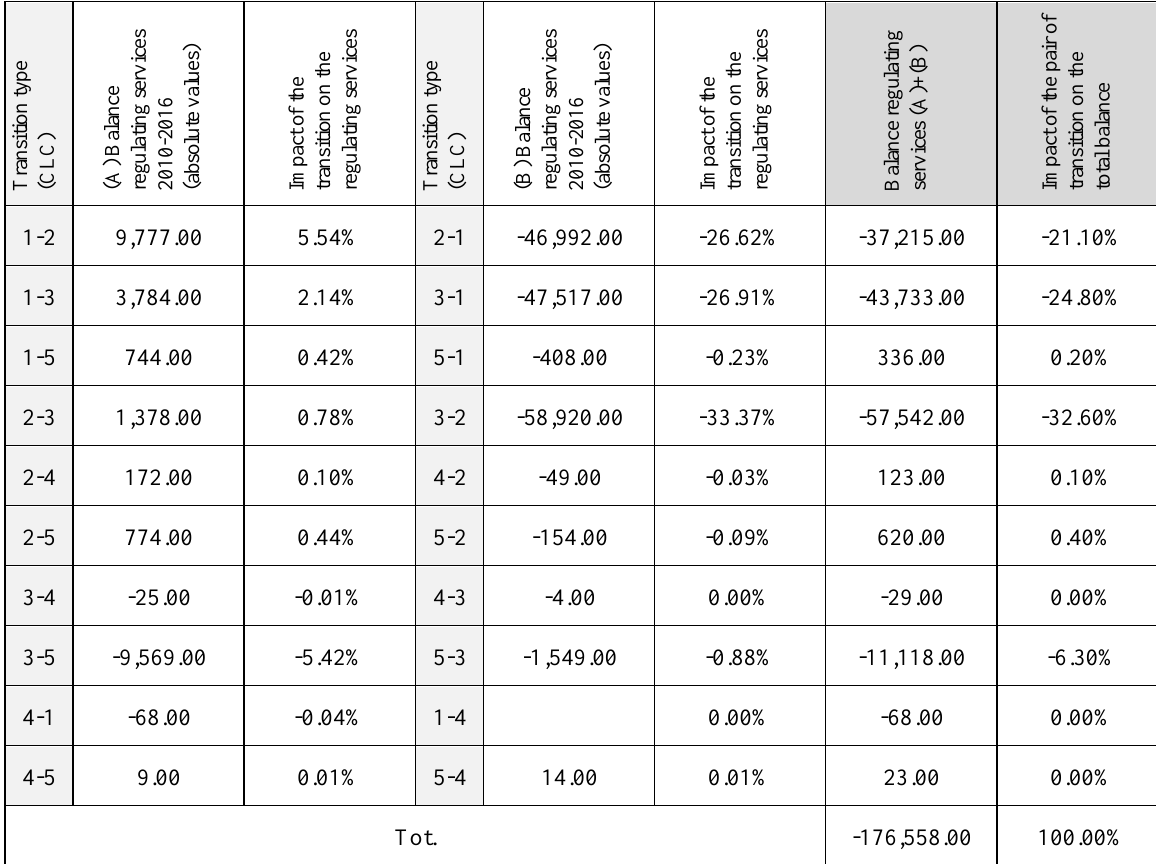
Table 8. Transition 2010-2016 of regulating: contributions of transitions between different LULC classes at the first classification level.